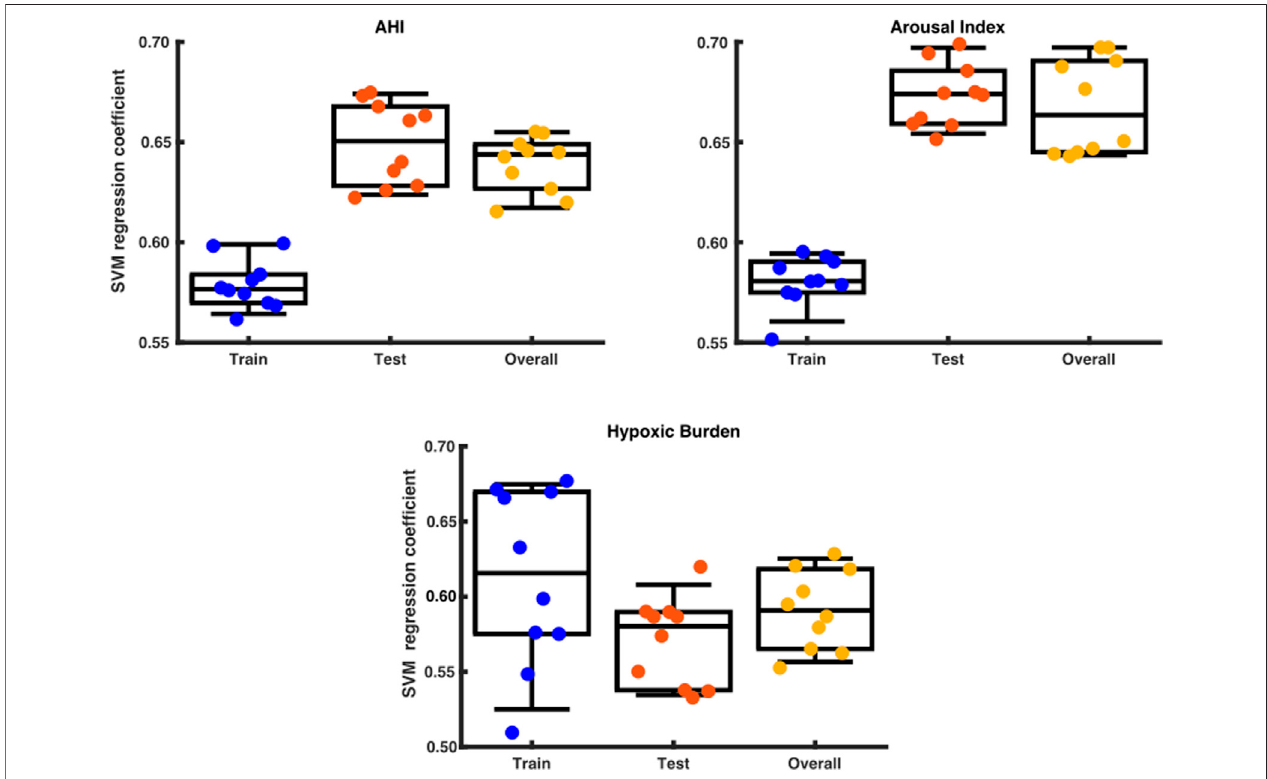
FIGURE 8 | Box plot with the distribution of a data set. The x axis shows the division into training set, test set and overall testing. The y-axis shows the SVM correlation coef fi cient.